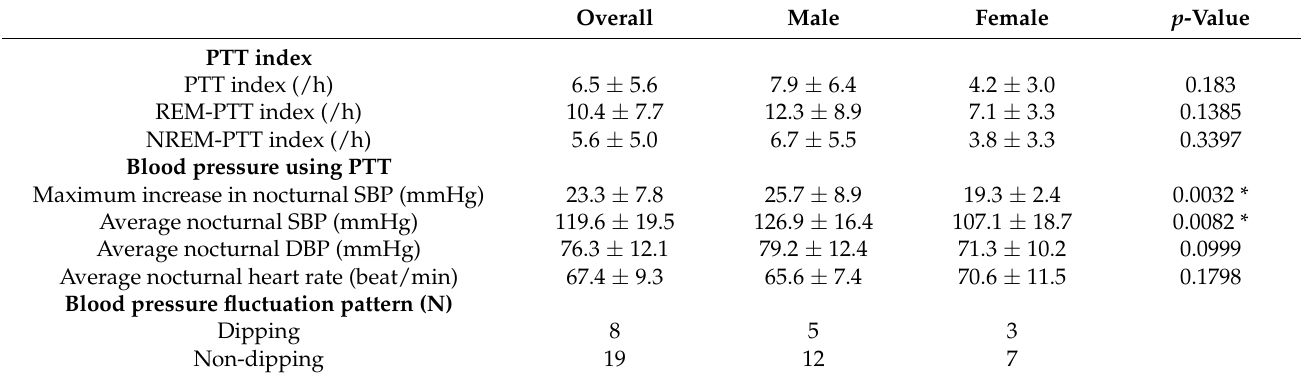
Figure 1. A comparison of PTT indexes during REM and NREM sleep. Continuous variables are expressed as mean ± Table 2. Characteristics of the PTT index, PTT-BP, and nocturnal SBP fluctuation standard deviation (SD). A comparison of the REM-PTT index and the NREM-PTT index ( p < 0.05) was considered statis-